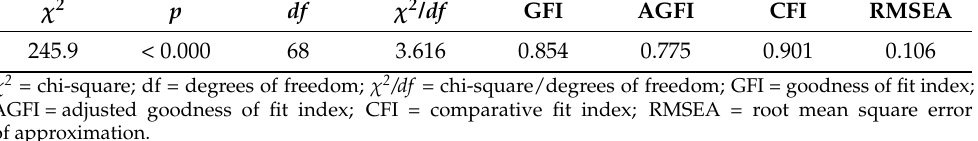
Figure 2. Hypothetical model among Behavioural Regulation, Sport Anxiety, Athlete Burnout and Performance Failure.